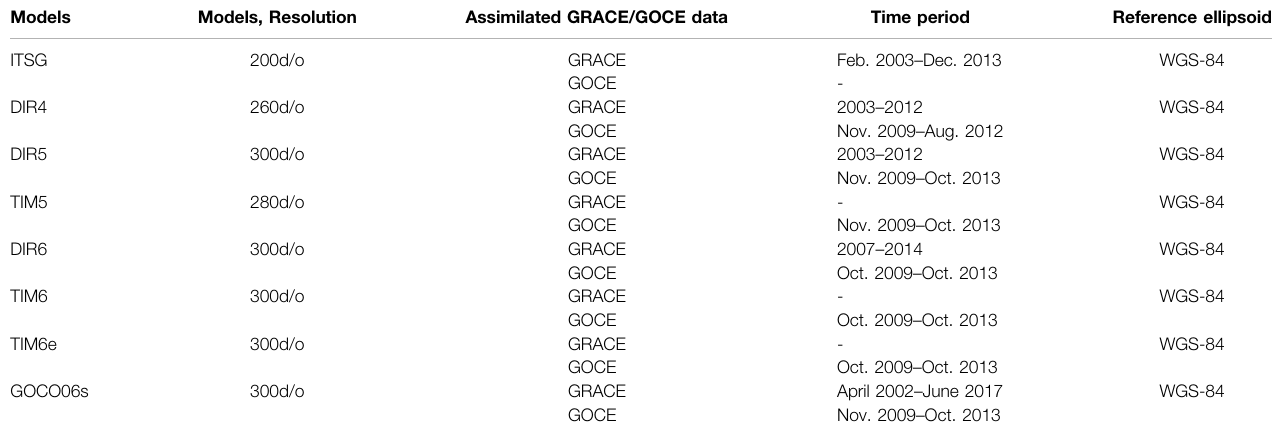
TABLE 1 | The summary of the